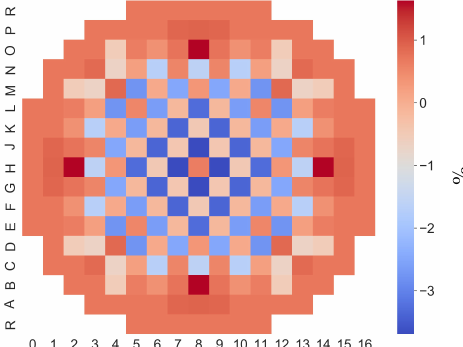
Figure 42. Average radial burnup discrepancy between the predicted P ave